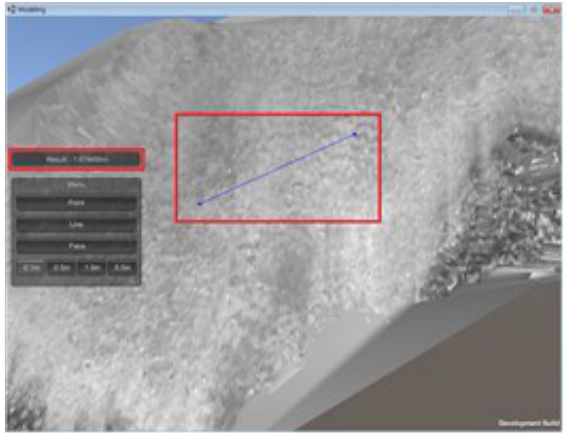
Figure 7. Measurement of Distance between Two Points